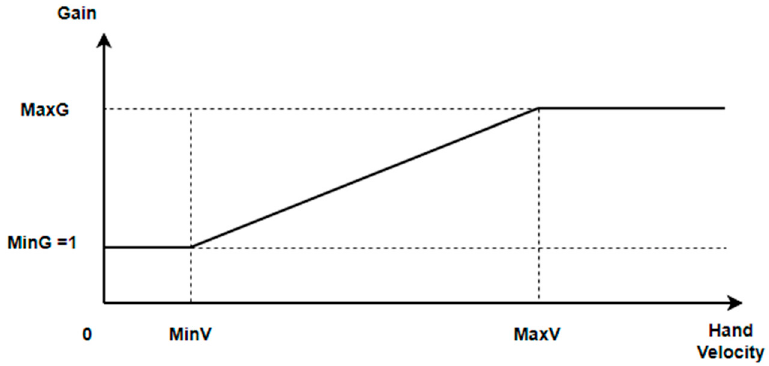
Figure 1. Interaction mode of velocity-oriented dynamic CD gain for kinesthetic interaction with a force-feedback device.